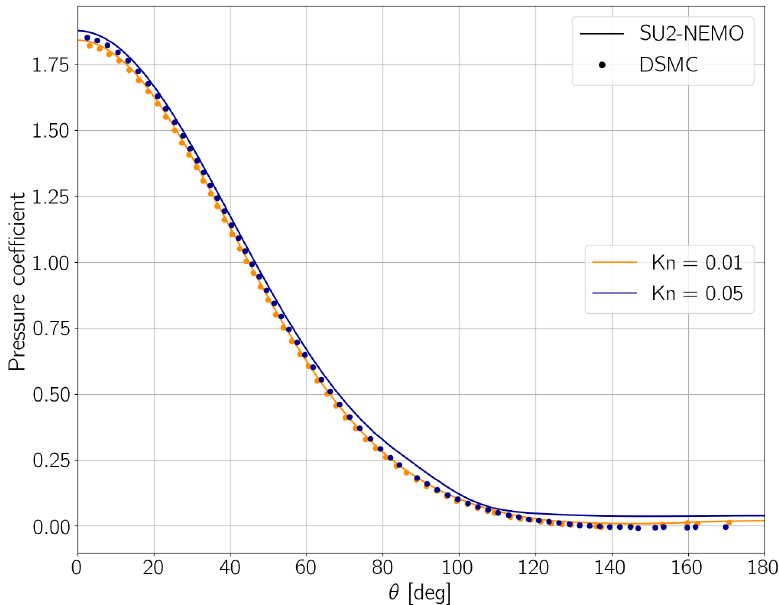
Figure 17. Pressure coefficient.